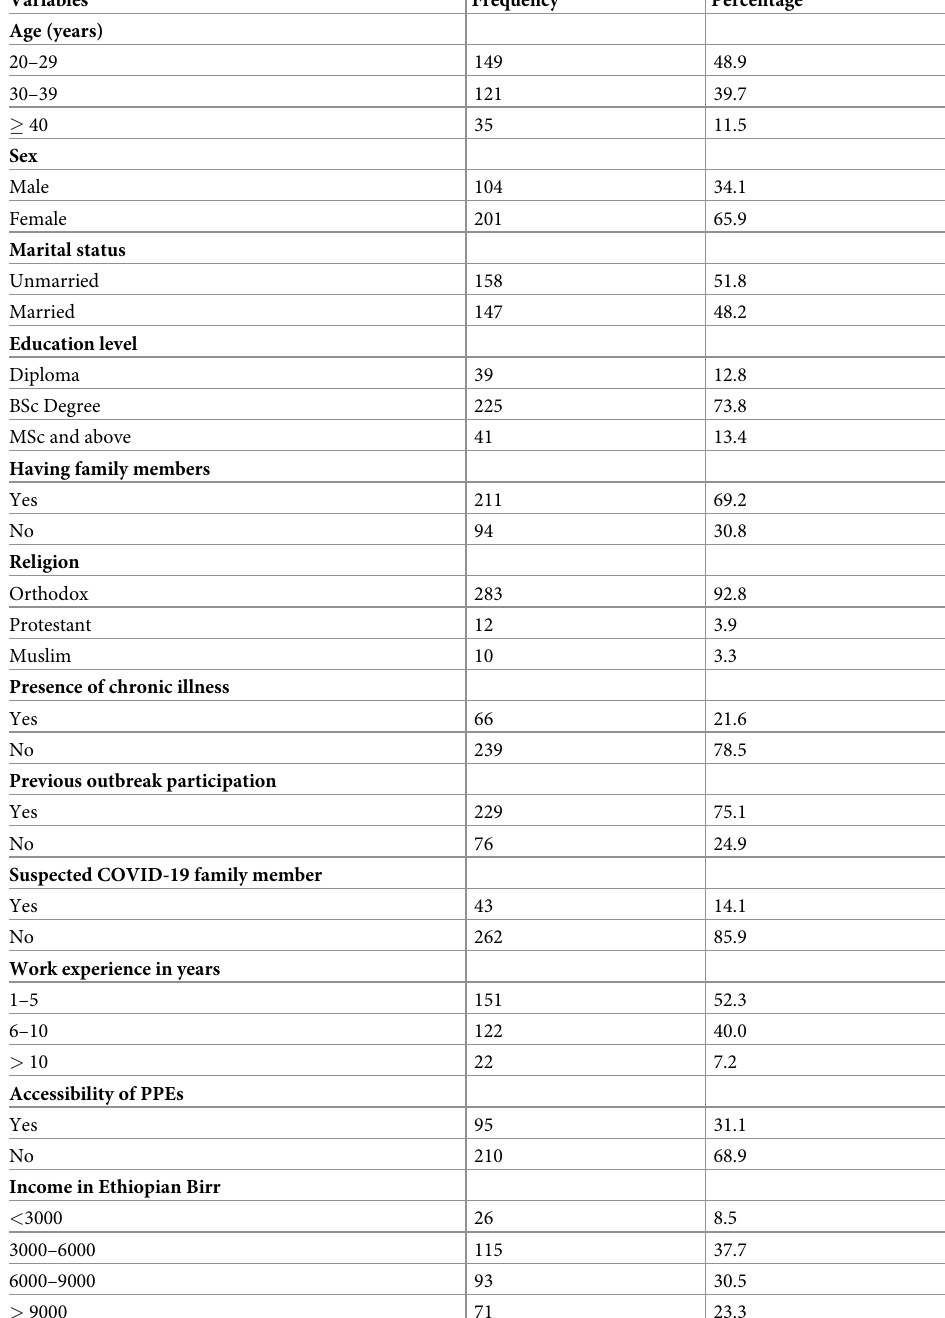
Table 1. Sociodemographic characteristics of HCWs at a Hospital of